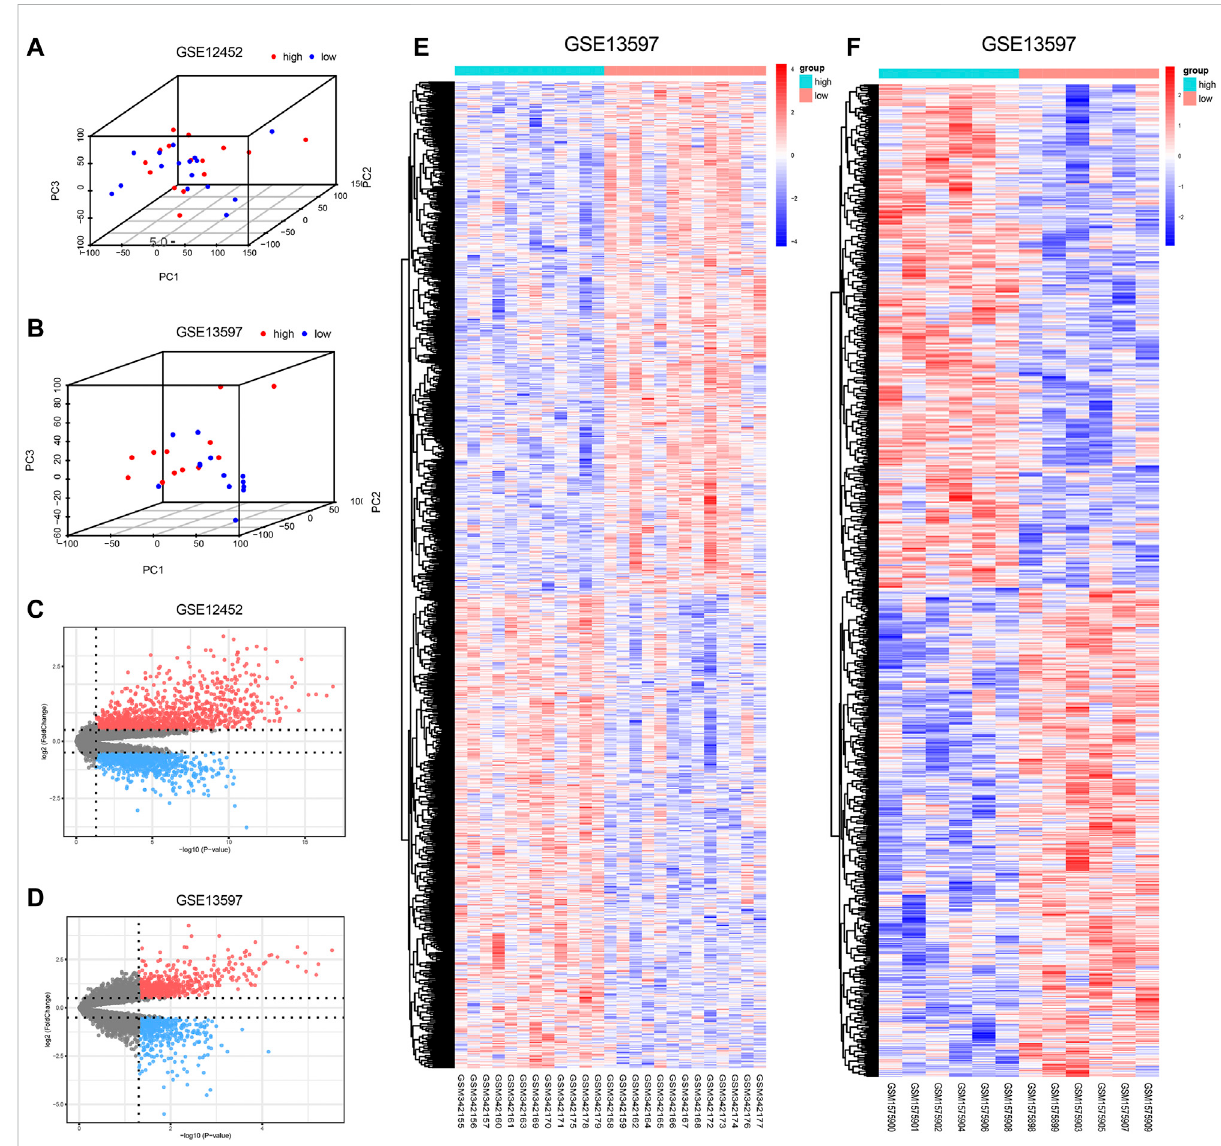
(Figure 7B). The results of GSEA of the top 20 NES of Hub genes are shown in Supplementary Table